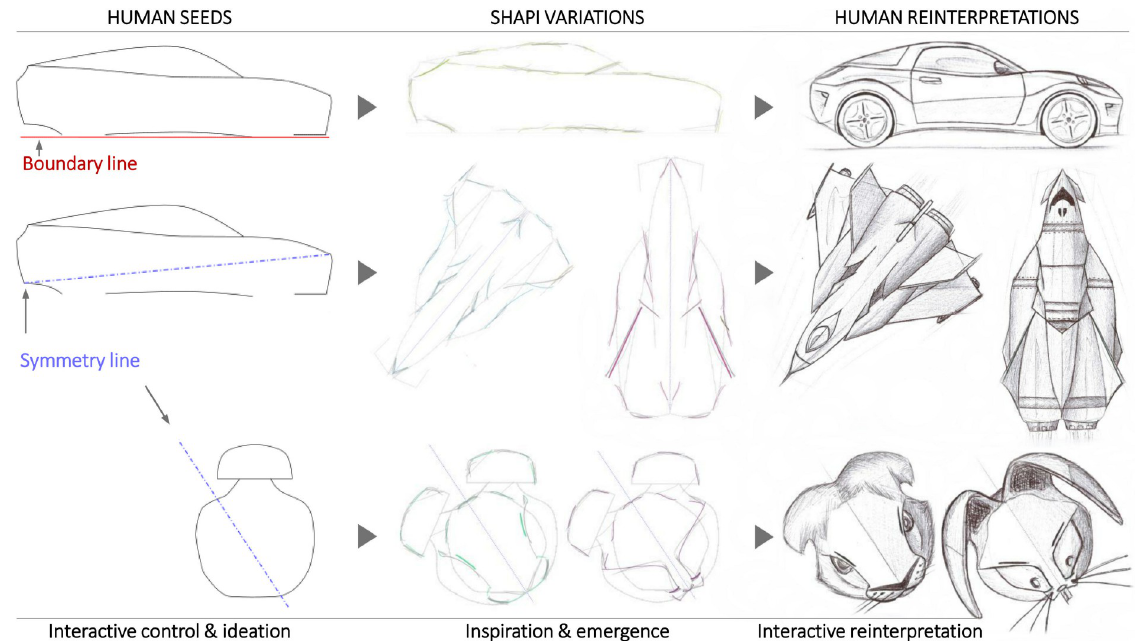
Fig 6. Explorations with different purposes. Input Seeds (left) are explored with Shapi (middle), and depending on the interactive controls, this may inspire reinterpretations as product concepts (top) or entirely new entities with divergent emerging patterns (bottom).